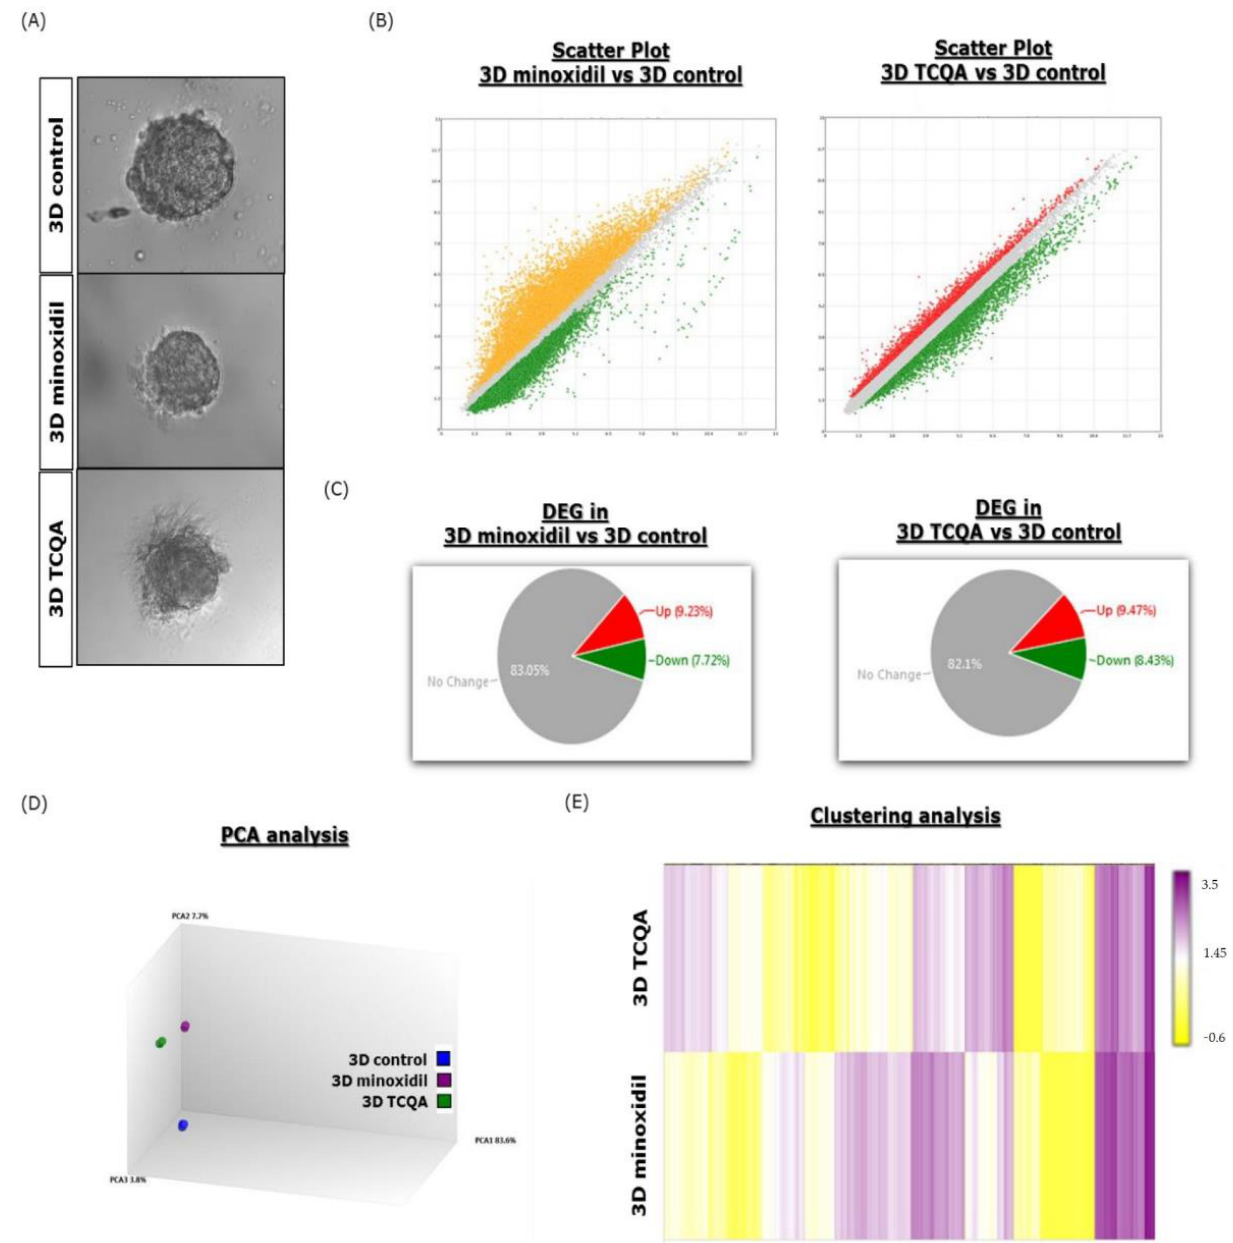
Figure 2. Microarray analysis of 3D HFDPCs treated with minoxidil and TCQA. ( A ) 3D spheroid HFDPCs treated with 0 (control), 0.1 µ M minoxidil, and 10 µ M TCQA for 48 h. ( B ) Scatter plot showing the DEGs. Yellow or red, green, and grey illustrate the upregulated, downregulated, and nonsignificant DEGs, respectively, of 3D treated with minoxidil and TCQA vs. 3D control. ( C ) The chart represents the DEG distribution, and the colours are assigned as above. ( D ) PCA analysis of